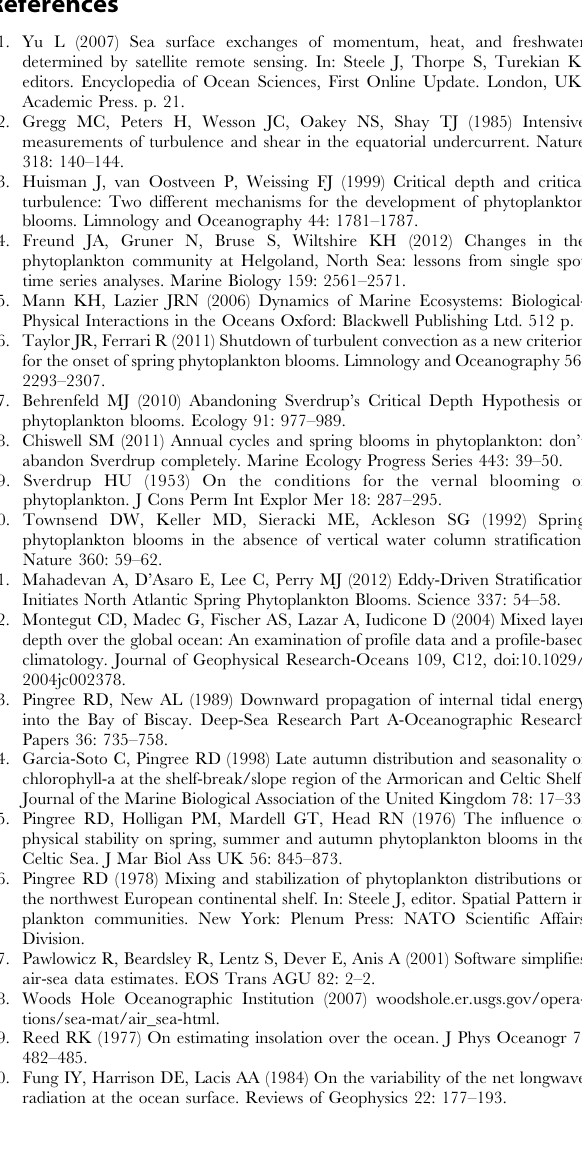
Table S2 Station L4 Zooplankton Taxa